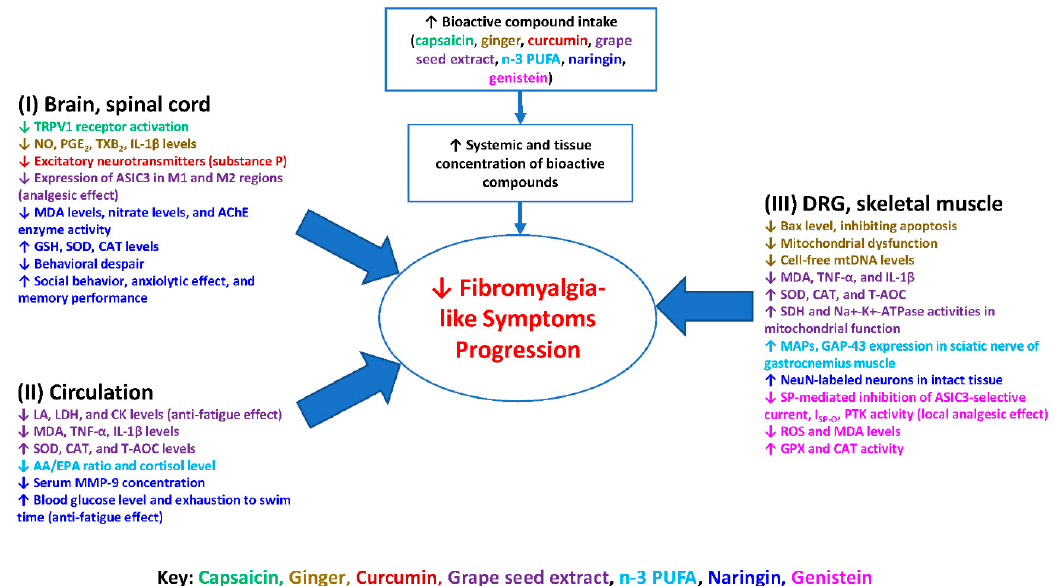
Figure 1. Diagram illustrates the potential actions of the bioactive compounds capsaicin, ginger, curcumin, grape seed extract, n-3 PUFA, naringin, and genistein on fibromyalgia-like symptoms. These compounds not only result in the production of pro-inflammatory cytokines, lipid peroxidation, and oxidative stress, but also result in upregulating antioxidant enzymes capacities in the nervous system, skeletal muscles, and circulatory system. The consequence is mitigation of the progression of fibromyalgia-like symptoms. Abbreviations: AA/EPA, arachidonic acid/eicosapentaenoic acid; CAT, catalase; CK, creatine kinase; CNS, central nervous system; DRG, dorsal root ganglion; GSH, glutathione; IL-1 β , interleukin-1 β ; LA, lactic acid; LDH, lactate dehydrogenase; MAPs, muscle action potentials; MDA, malondialdehyde; MMP-9, matrix metalloproteinase-9; NO, nitric oxide; n-3 PUFA, n-3 polyunsaturated fatty acids; PGE2, prostaglandin E2; PNS, peripheral nervous system; ROS, reactive oxygen species; SDH, succinate dehydrogenase; SOD, superoxide dismutase; T-AOC, total antioxidant capacity; TNF- α , tumor necrosis factor- α ; TXB2, thromboxane B2.